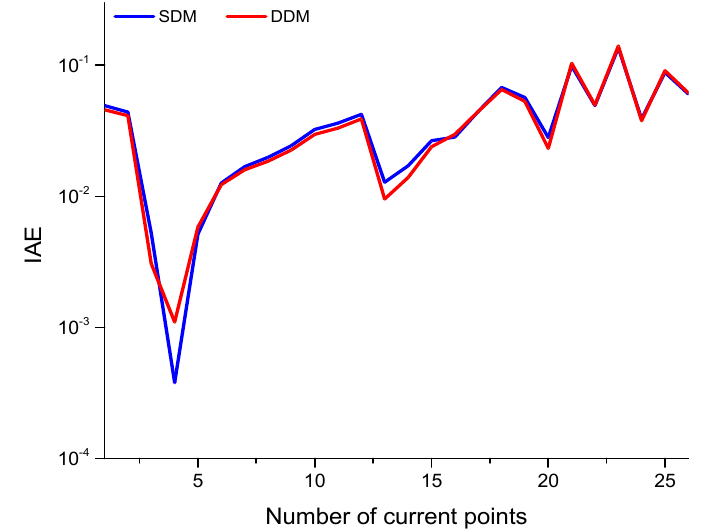
Figure 14. IAE for SDM and DDM, JKM330P-72 PV module for curve 1.